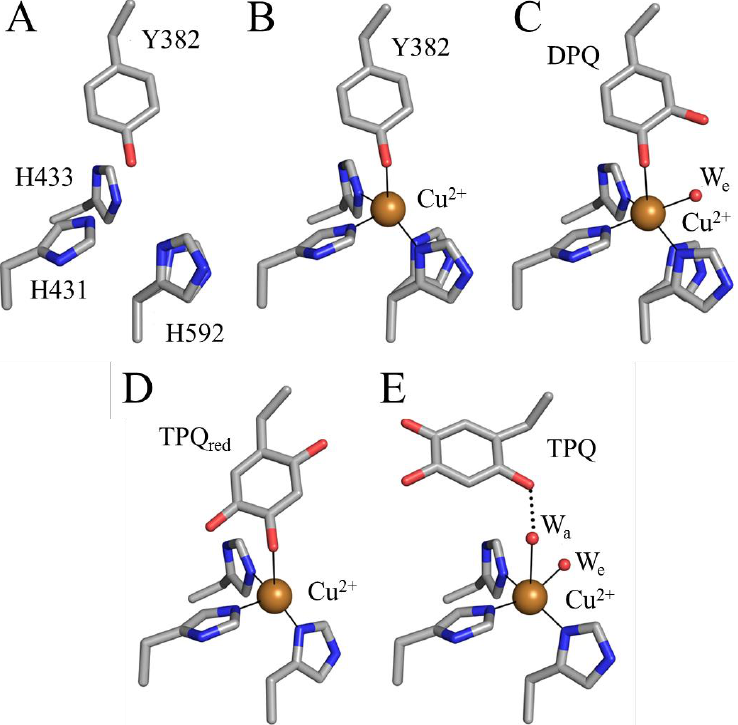
Figure 5. Structurally characterized TPQ biogenesis intermediates in AGAO [58,69]: ( A ) apoAGAO (PDB code 1avk); ( B ) apoAGAO/Cu(II) complex (PDB code 1ivu); ( C ) dopaquinone (DPQ)-containing early intermediate (PDB code 1ivv); ( D ) 2-electron reduced TPQ (TPQ )-containing late intermediate (PDB code 1ivw) and ( E ) holoAGAO red generated in the crystal (PDB code 1ivx). Residues are drawn in stick and colored by atom type (carbon, grey). Copper ions are drawn as gold spheres, and water molecules as small red spheres. Solid lines indicate metal-ligand interactions, and dashed lines indicate hydrogen